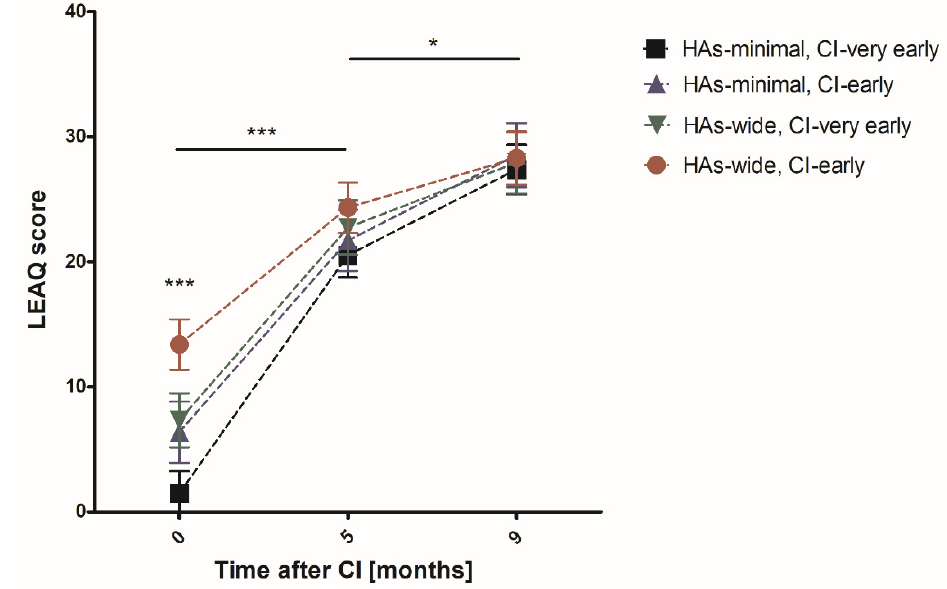
Figure 5. Distribution of an average LEAQ score of patients with DFNB1 HL at subsequent time intervals (mean ± 95% confidence interval). Asterisks indicate statistically significant differences observed between patients with minimal HAs responses and very early CI vs. patients with wide HAs responses and early CI. Asterisks represent statistical significance, * p < 0.05, *** p < 0.001. During the analyzed implantation period, no sex-dependent differences were observed.